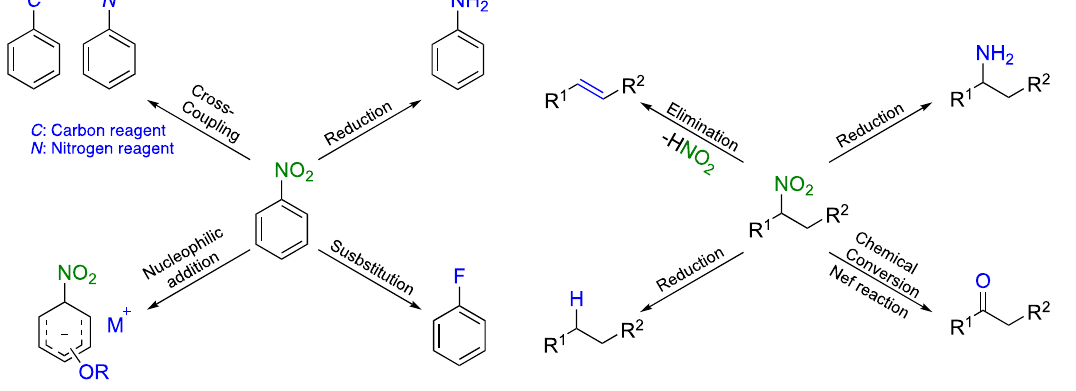
Scheme 1. Properties of a nitro